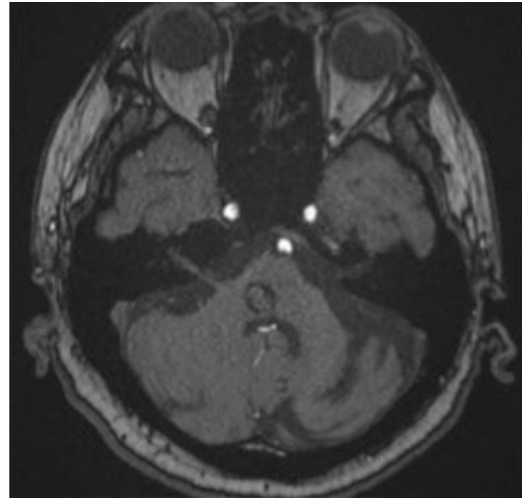
Figure 5: Time of flight image from the patient’s cranial magnetic resonance